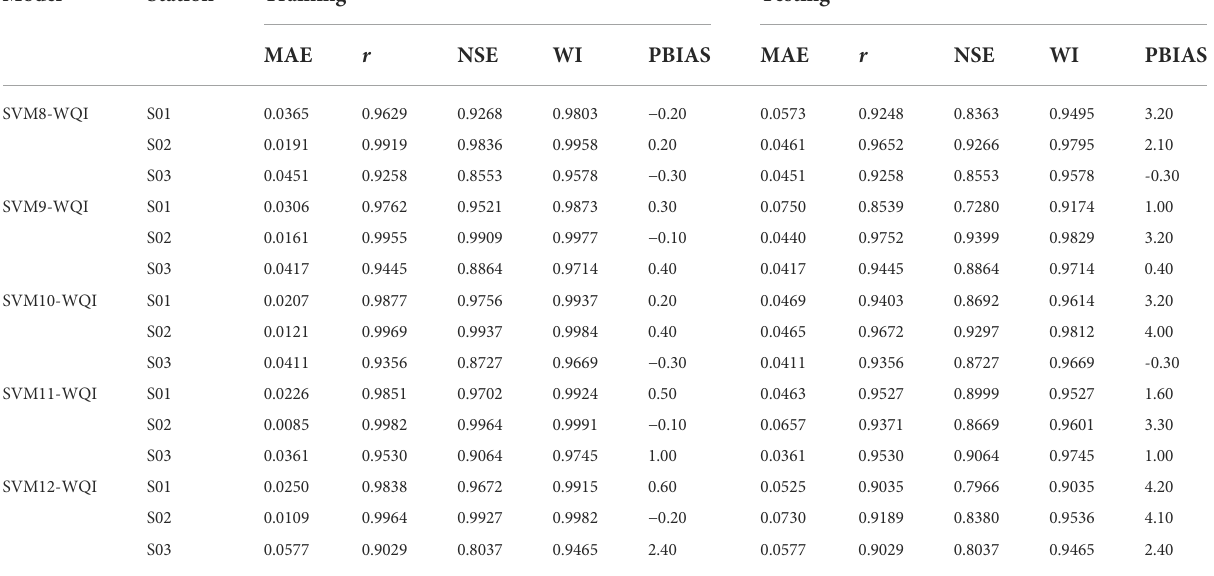
TABLE 9 Performance evaluations for the third scenario. Model